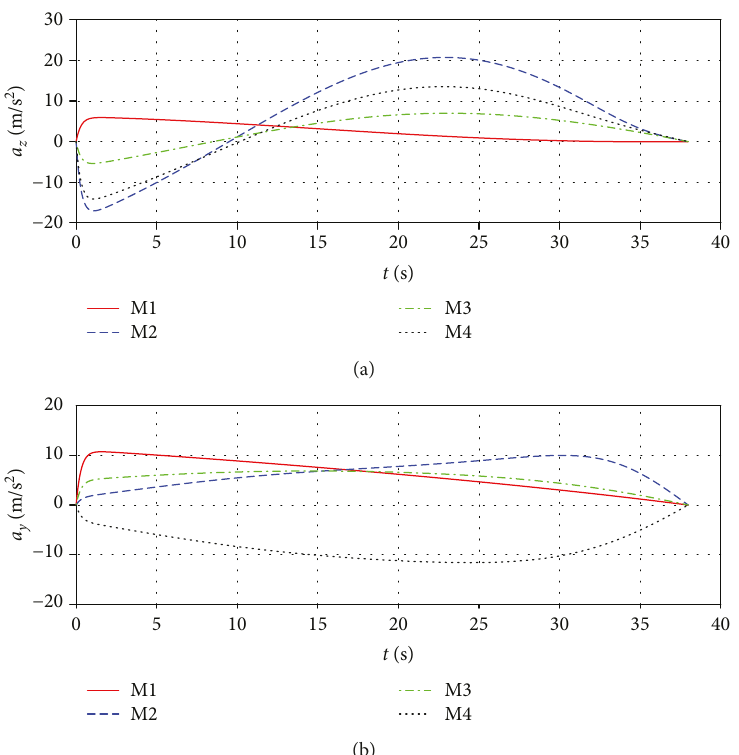
Figure 10: Missile acceleration with impact time